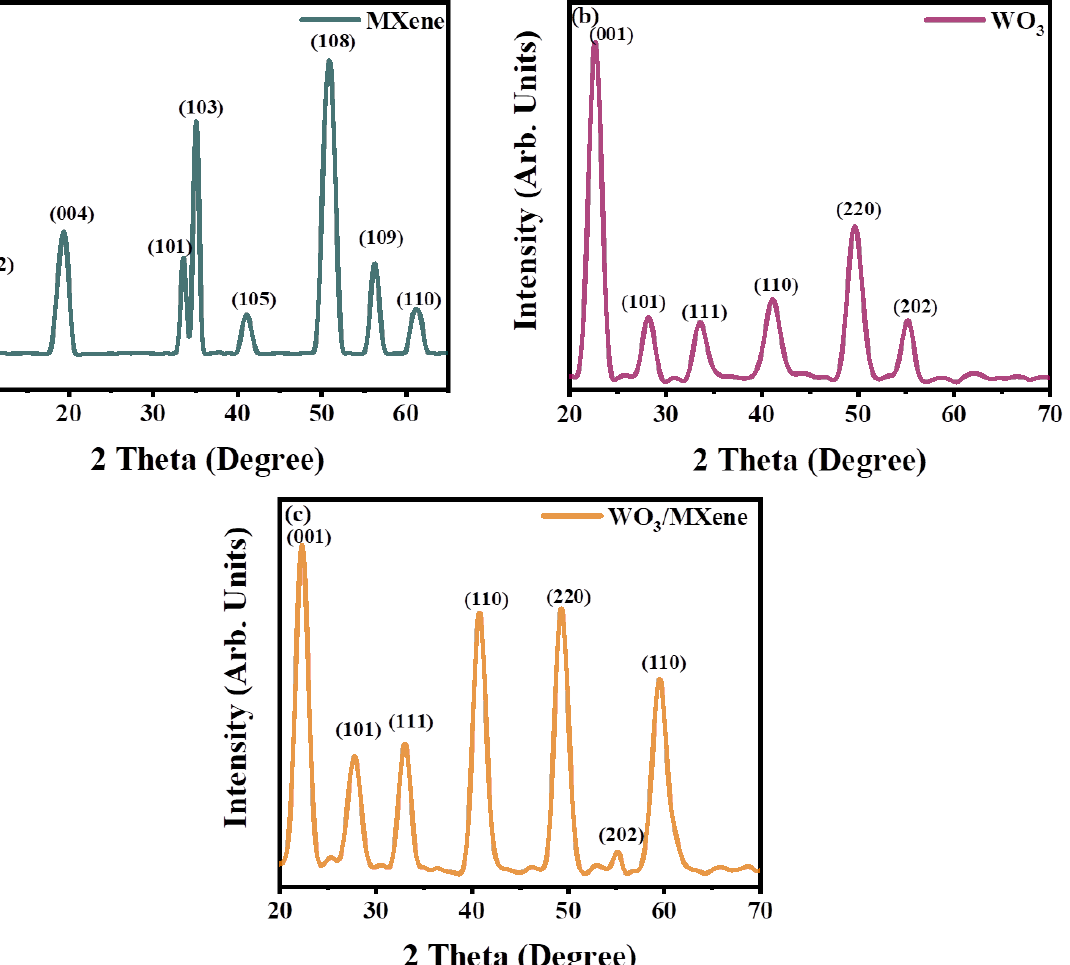
Figure 3. XRD spectra of ( a ) MXene, ( b ) WO 3, and ( c ) WO 3 /MXene nanocomposite. The XRD pattern was used for studying the phases of the composite (WO 3 / MXene). The pure MAX XRD pattern showed 2 θ peaks at 9.11 ◦ , 18.7 ◦ , 33.58 ◦ , 35.65 ◦ , 38.61 ◦ ,41.44 ◦ , 51.93 ◦ , 56.08 ◦ , and 60.23 ◦ , which corresponds to Miller indices (002), (004), (101), (103), (104), (105), (108), (109), and (110), respectively [52,53]. Due to the presence of the Al, the pure MAX powder showed a characteristic peak at 2 θ = 38.61 ◦ , which corresponds to (104). Al was completely etched by using HF in order to fabricate good-quality MXene [54,55]. During the first 2 h of the reaction, the peak intensity at 38.61 ◦ increased [56]. After 24 h of the reaction, the characteristic peak of MAX at (104) vanished, as shown in Figure 3a. A peak shift was also observed in the peak at 9.11 ◦